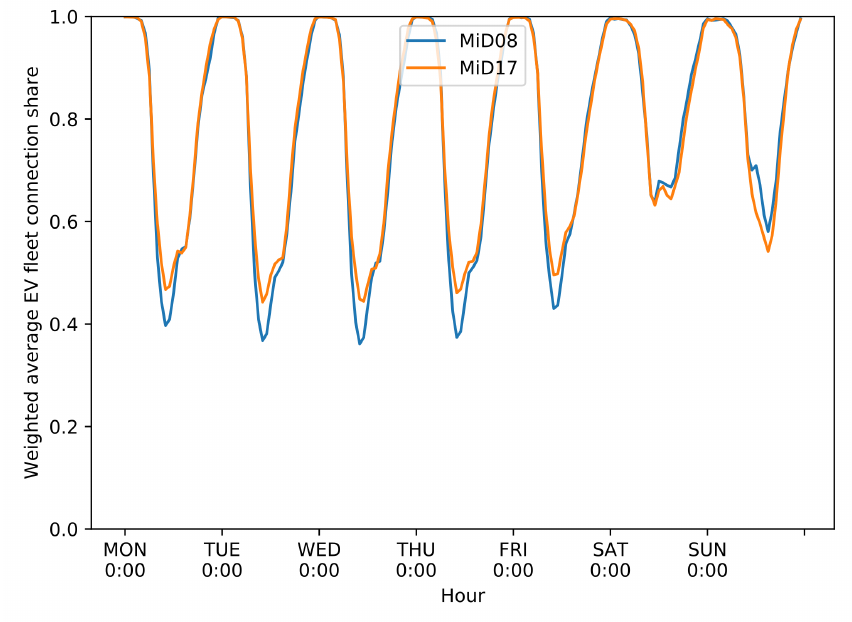
Figure 3. Weighted average grid connection for electric vehicle fleet differentiated by